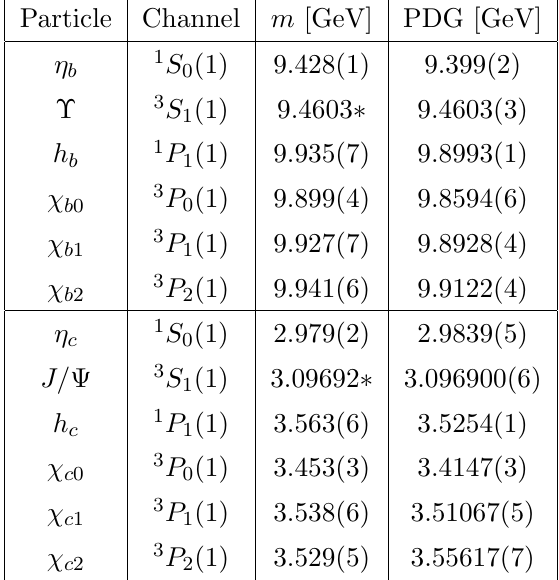
Table 3 . Mass estimates for the ground states of bottomonium and charmonium at zero tempera- ture from the e(cid:11)ective mass (cid:12)ts, compared to the experimental PDG